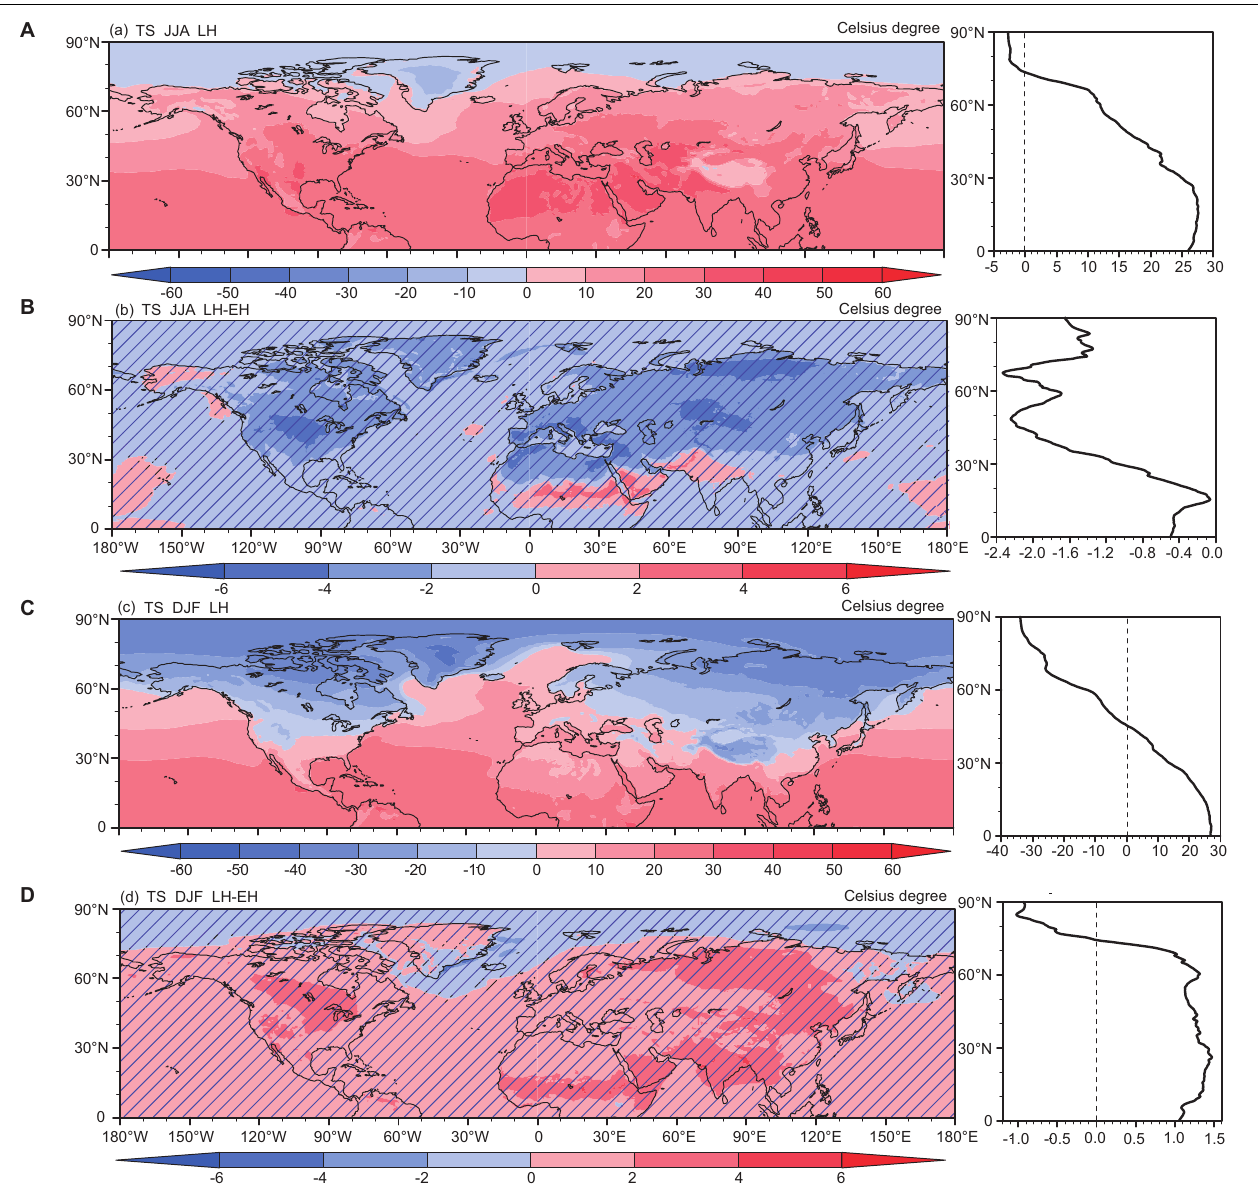
FIGURE 10 | Surface temperature distributions and the zonal mean temperature profiles. Summer and winter surface temperature distributions and zonal mean temperature profiles in LH (A,C) and the LH-minus-EH difference (B,D) . The line indicates the differences at the 95% significance level.